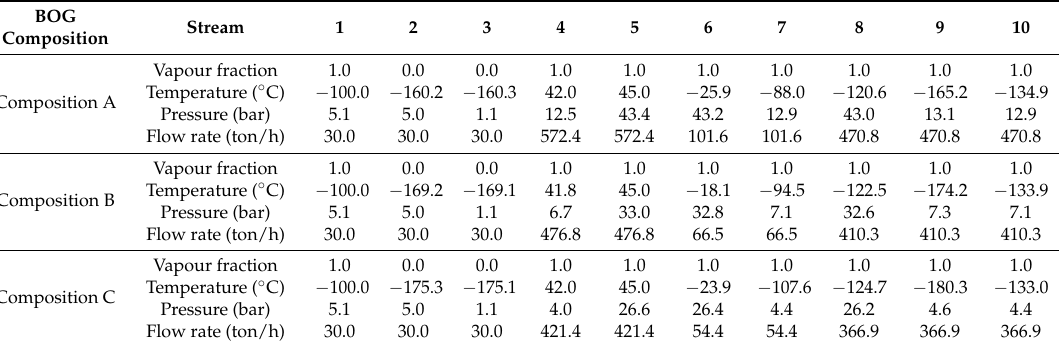
Table 5. Basic process specifications of System